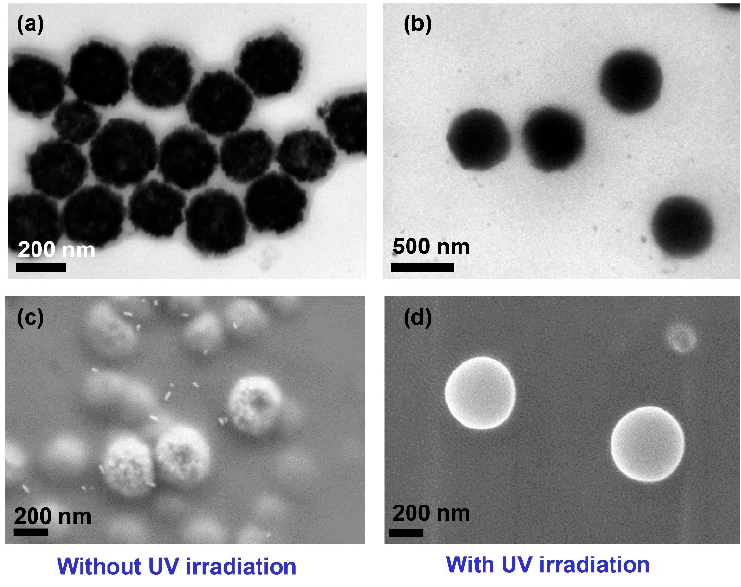
Figure 6. TEM ( a , b ) and SEM ( c , d ) images of HPNCs prepared with and without the photo-crosslinking process.